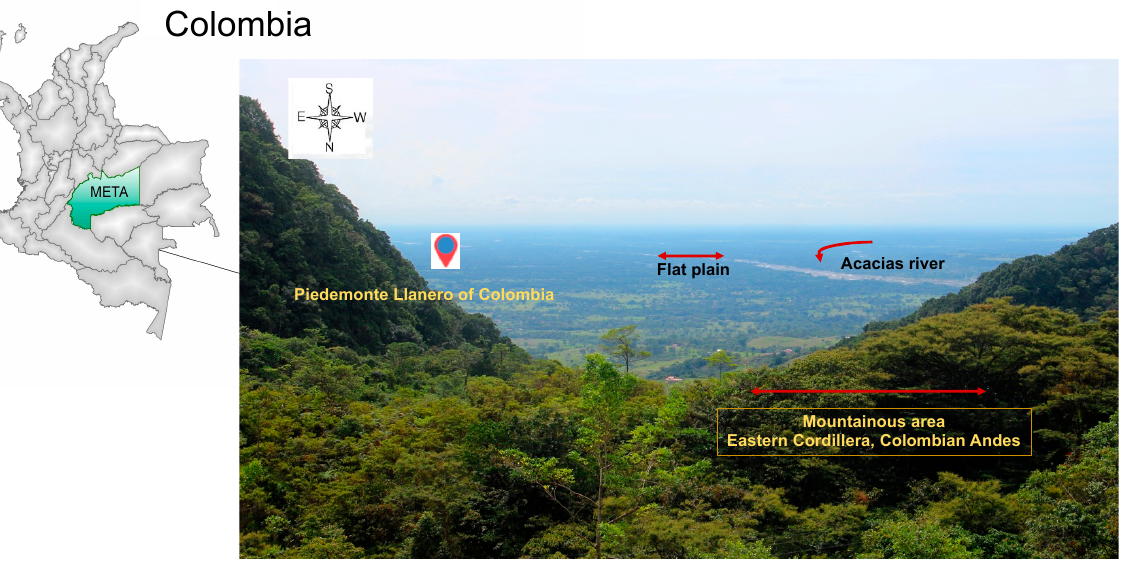
Figure 1. Study area. Note the dense vegetation layer (transition between the vegetation of the mountain and plain, or Piedemonte), and the strong escarpment, transverse to the N-S line, which acts as a screen against clouds. JMTG owns image.